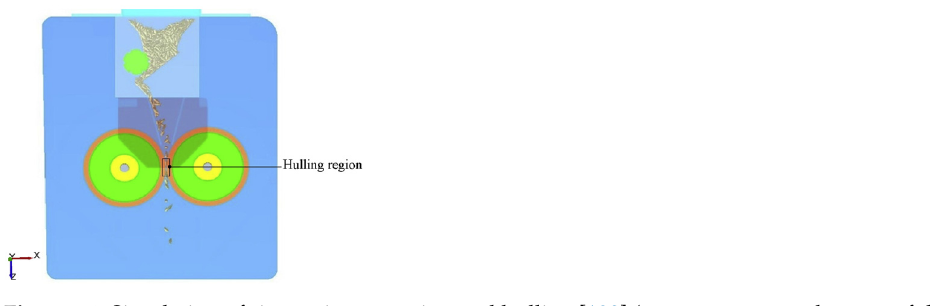
Figure 14. Simulation of rice grain conveying and hulling [190] (x,y,z reperesents the axes of the 3D DEM